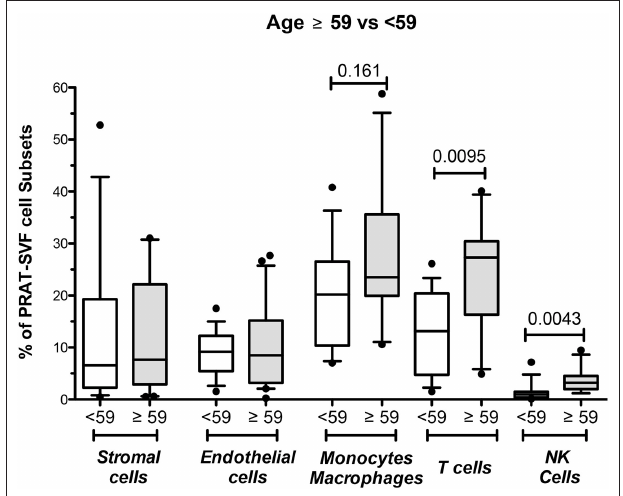
FIGURE 5 | Analysis of perirenal adipose tissue stromal vascular fraction (PRAT-SVF) in young vs. aged donors. PRAT-SVF was analyzed according to donor age when stratified in aging donors ( ≥ 59 years, n = 29) and younger donors ( < 59 years, n = 24). Percentages in stromal and endothelial cells were not different between the aging and younger donors. However, the aging donors presented a trend for increased representation of the CD45 + CD14 + monocyte macrophage cell subset and a significantly higher percentage of T and NK cells.